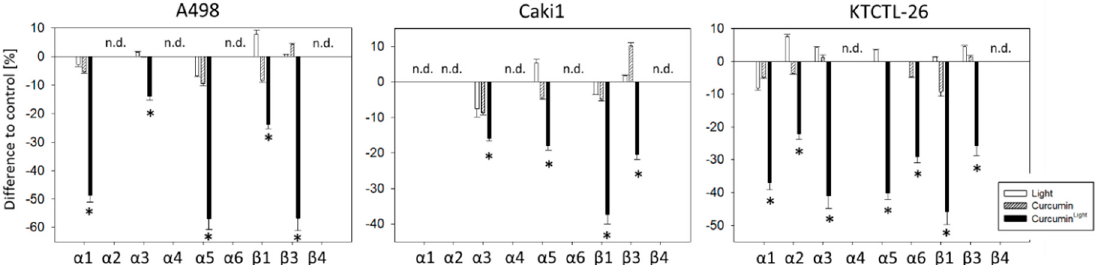
Figure 6. Influence of curcumin (0.2 µg/mL), light, or curcumin Light on the integrin expression profile of A498, Caki1, and KTCTL-26 cells. The untreated control is set to 0% (line drawn at 0%). Values are means ± SD, n = 6. * indicates significant difference to controls ( p = 0.00512). n.d. = not or hardly detectable.